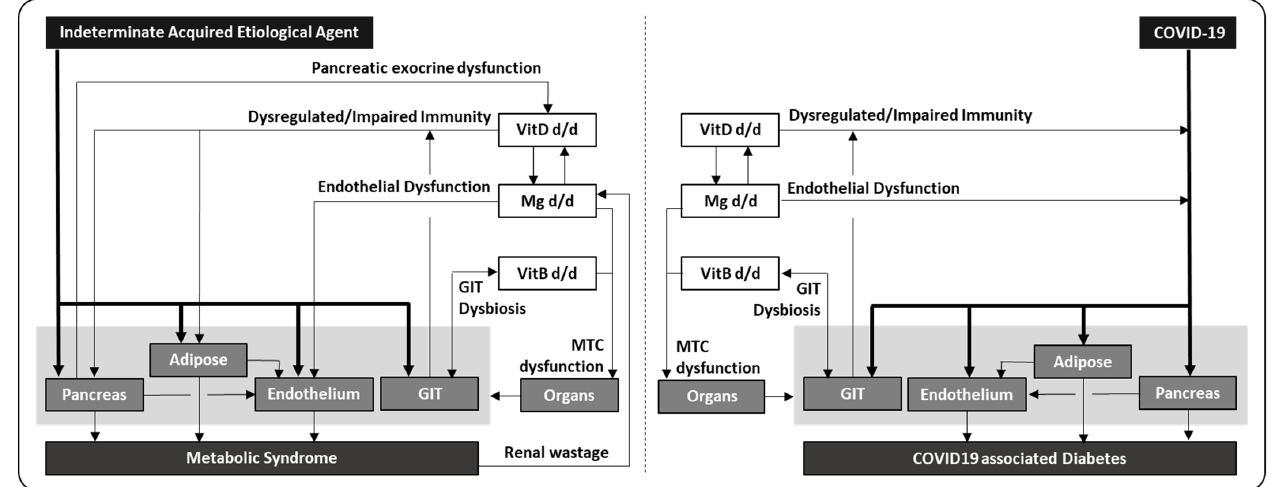
Figure 1. Comparison between classical and COVID-19-associated metabolic syndrome. In COVID-19, SARS-CoV-2 can infect pancreas and adipose tissue directly, leading to impaired insulin production and insulin resistance, while endothelium and gut involvement can result in immunothrombosis and microbial dysbiosis. Concomitant deficiency in essential micronutrients will aggravate COVID-19, e.g., hypovitaminosis D causing deregulated immune response and hyperin- flammatory tissue damages, hypomagnesemia causing endothelial dysfunction and excessive thrombosis, as well as hypovitaminosis B causing gut dysbiosis and impaired immunity. In addition, both magnesium and vitamin B deficiency can affect mitochondrial function, further aggravating insulin resistance and hyperglycemia. Together, these tissue dysfunctions and micronutrient deficiencies play an important role in contributing to the development of COVID-19-associated diabetes mellitus ( right panel ). In metabolic syndrome, patients can present with deranged function in pancreas, adipose, endothelial and gut tissue, but the exact etiological agent and early pathological events are generally indetermi- nate at the time of diagnosis. Vitamin D, magnesium and vitamin B deficiencies are common in these patients, which are both a consequence of the deranged metabolic state as well as contributing factors in sustaining the metabolic derangement. This vicious cycle may ultimately spiral downwards and culminate in classical metabolic syndrome if it remains unabated. In comparison to COVID-19, it is evident that the important tissue dysfunctions and micronutrient deficiencies are similar in both diseases, though a self-sustaining vicious cycle has been demonstrated mainly in classical metabolic syndrome. Therefore, SARS-CoV-2 may serve as a prototype of an acquired etiological agent, and COVID-19-associated diabetes may provide the opportunity to understand the missing initial factors and events, in the development of classical metabolic syndrome ( left panel